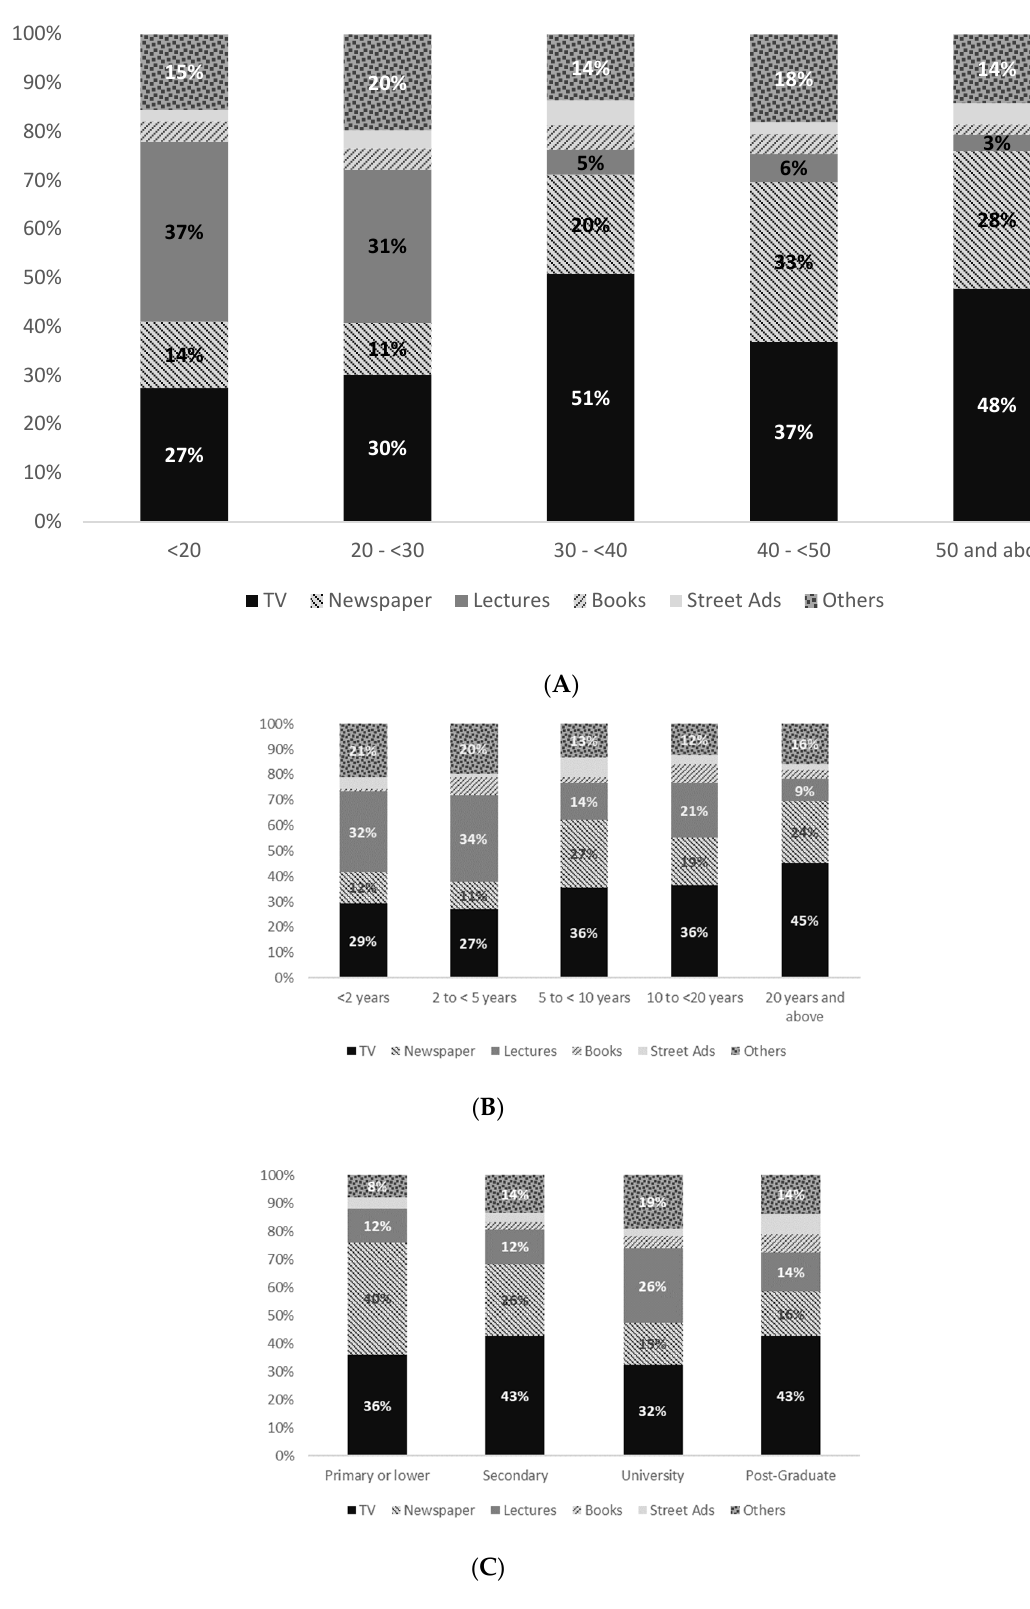
Figure 8. The means to access the knowledge related to Sponge City (Q8a) among ( A ) age groups; ( B ) residential time; ( C ) education level. ( B ) residential time; ( C ) education